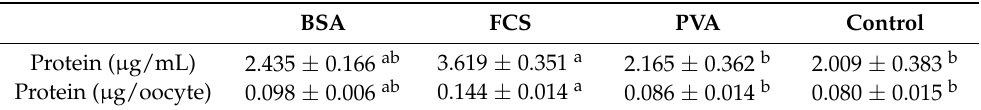
Table 3. Total protein amounts in bovine oocytes matured in media supplemented with BSA, FCS, and PVA. BSA FCS PVA Control Protein ( µ g/mL)